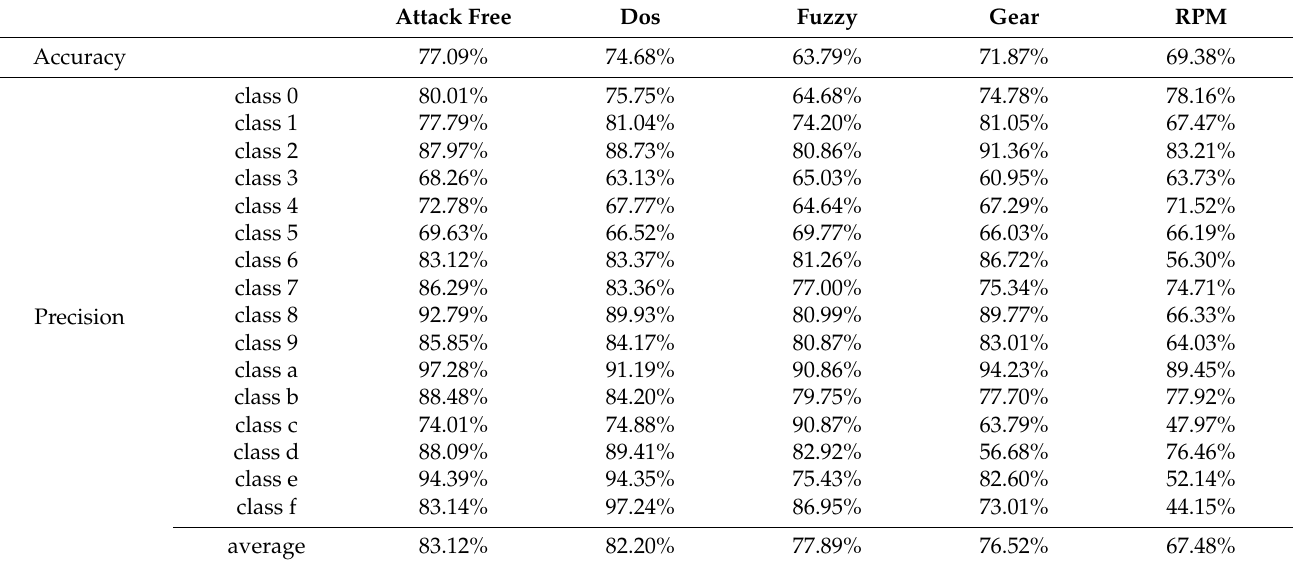
Table 1. Accuracy and precision of the RNN generator. Attack Free Dos Fuzzy Gear